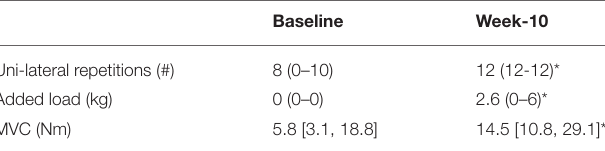
TABLE 3 | Training related measures.